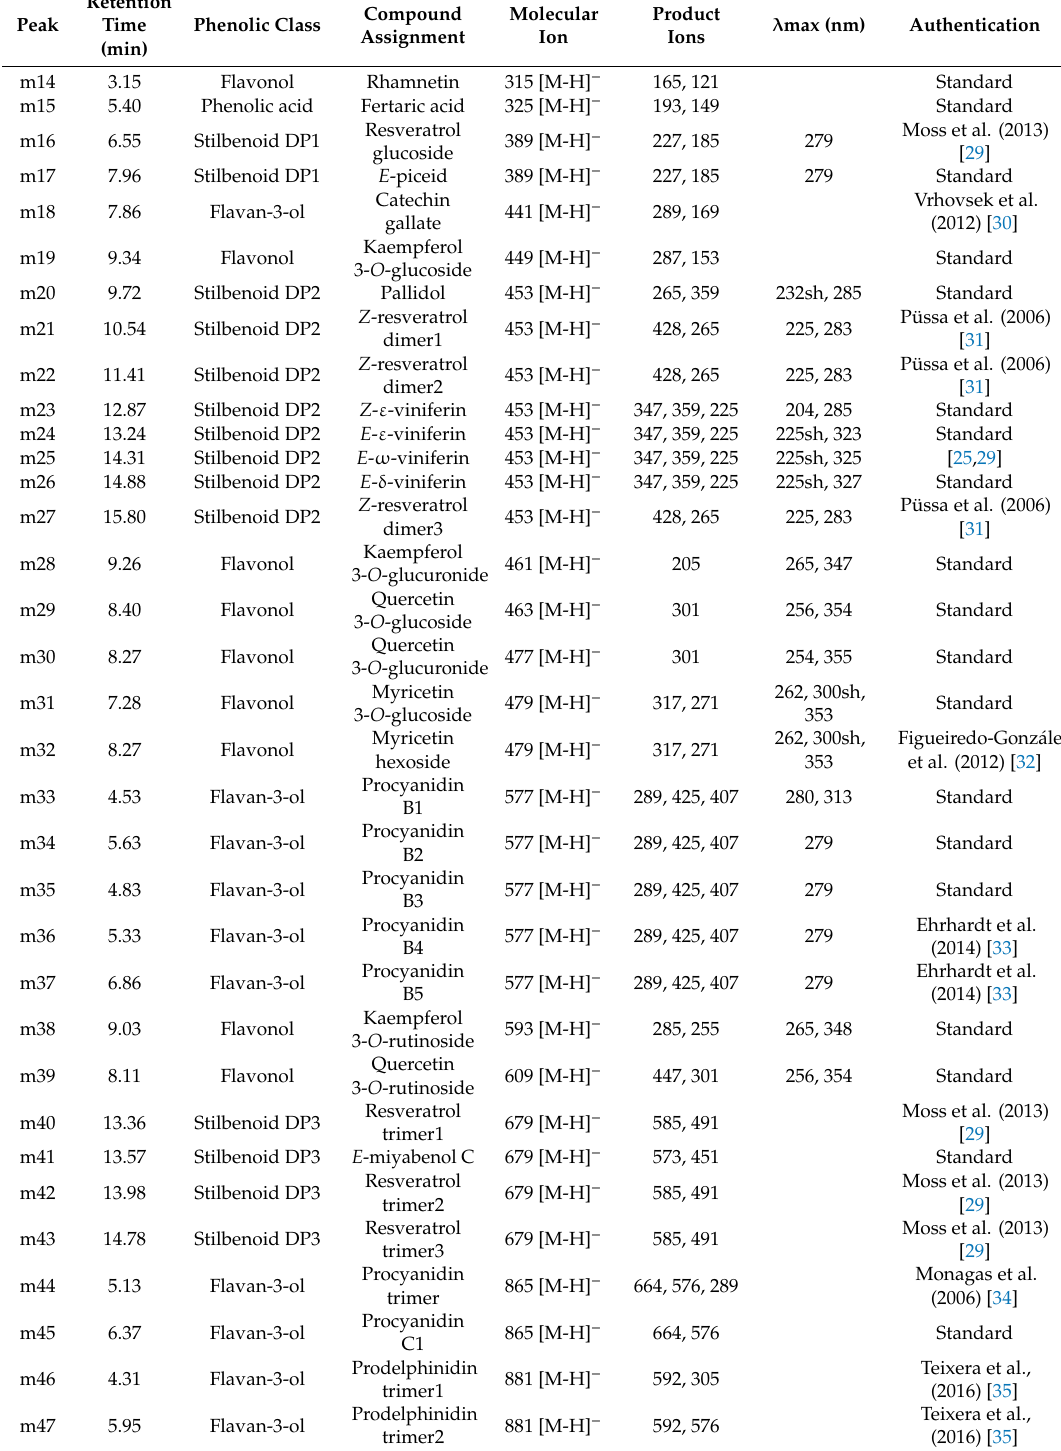
Figueiredo-Gonz á lez et al. (2012)